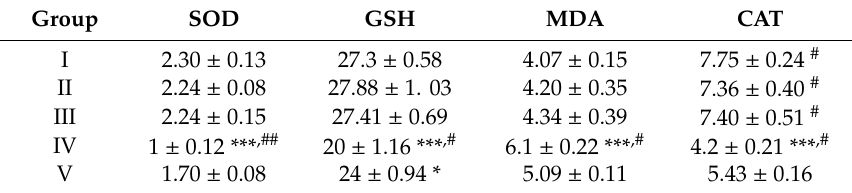
Table 1. Levels of enzymic antioxidants in the brain of control and experimental animals. Group SOD GSH MDA CAT I 2.30 ±